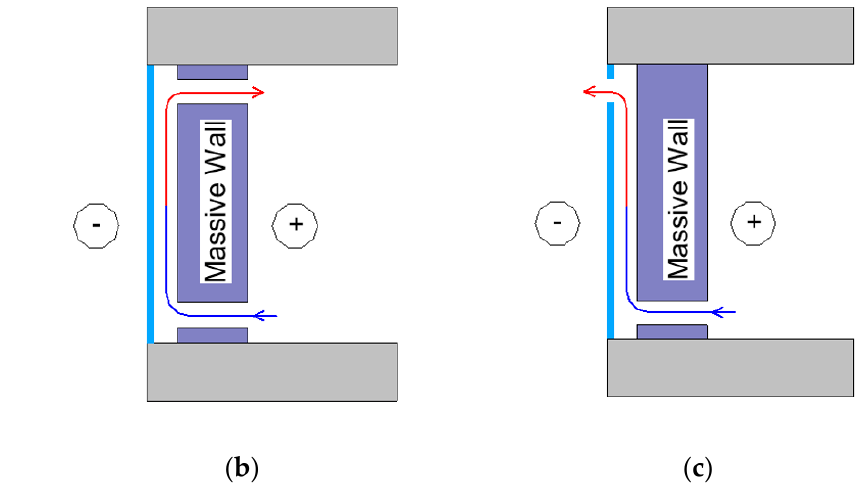
Figure 1. Trombe’s wall modes: ( a ) winter night; ( b ) winter day; and, ( c ) summer day (data from ref. [34]).